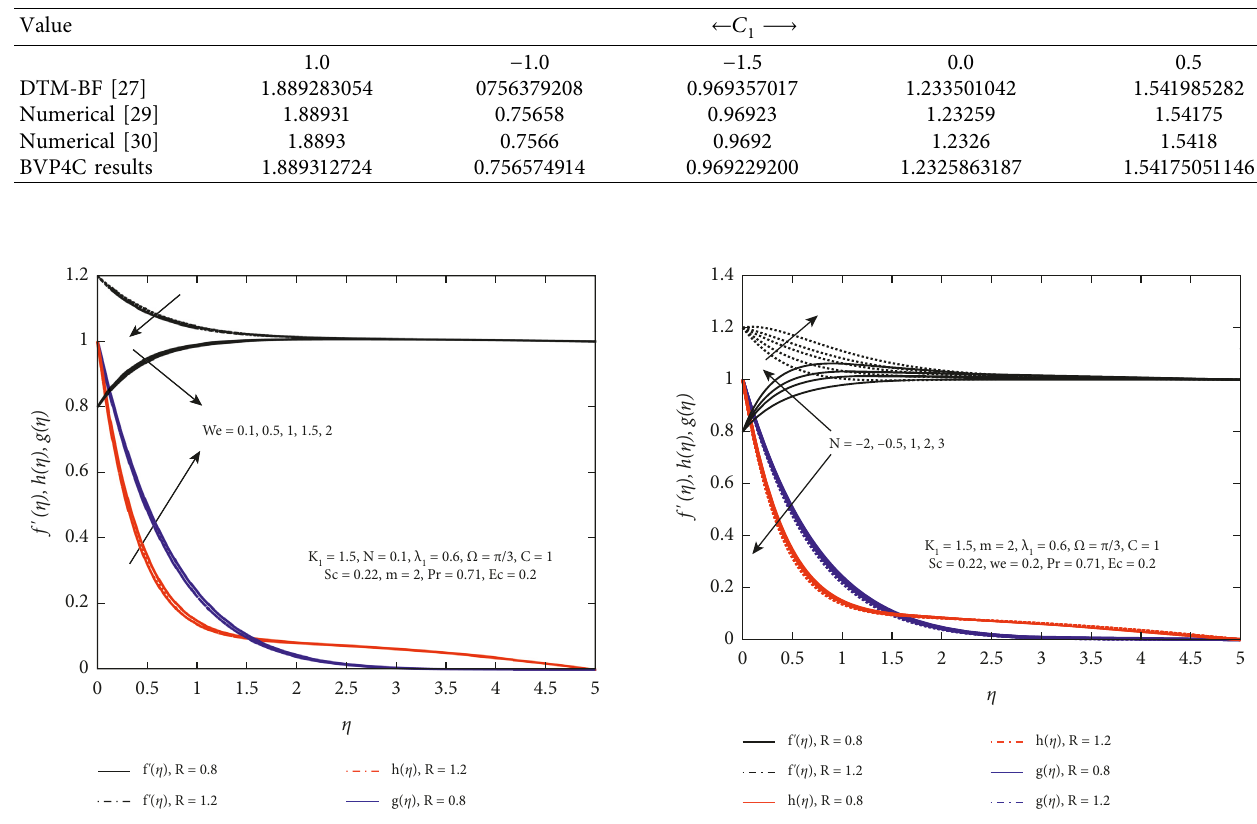
Table 1: Validated (comparative) values of f